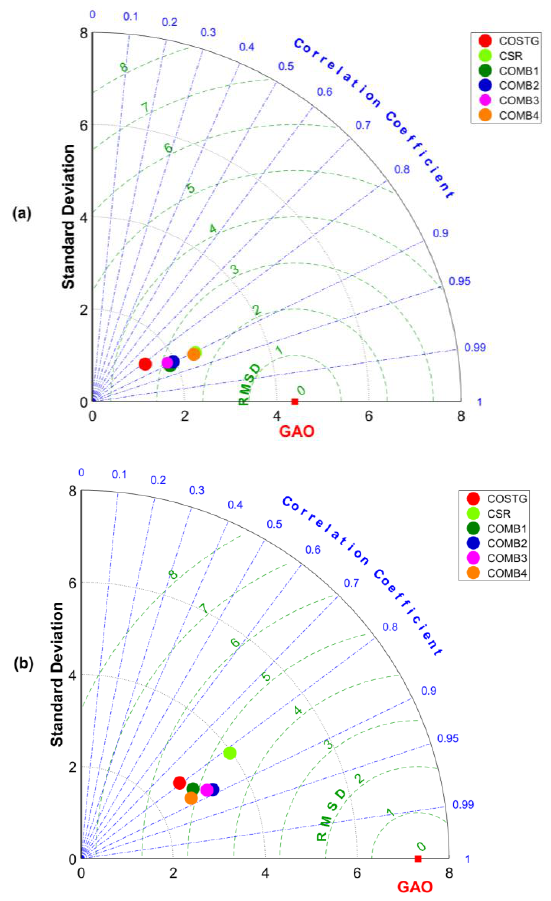
Figure 7. Taylor diagrams showing a comparison of seasonal χ 1 ( a ) and χ 2 ( b ) components of GAO (treated as a reference) with gravimetric excitation determined from a single GRACE/GRACE-FO solution (CSR), combined GRACE/GRACE-FO solution (COST-G), and the four combined solutions developed in this study (COMB1, COMB2, COMB3, and COMB4). The critical value of the correlation coefficient for seasonal variation for 90 independent points and a 95% confidence level is 0.17, and the standard error of the difference between the two correlation coefficients is 0.15. To further study seasonal variations, we decomposed them into annual prograde, annual retrograde, semiannual prograde, and semiannual retrograde parts and show their amplitudes and phases (Figures 8 and 9), which is a common approach for testing such oscillations [5,6,20,62]. Figure 8 demonstrates that for the observed hydrological signal in PM excitation (GAO), the retrograde component is characterized by higher amplitudes than for the prograde term, whereas for gravimetric excitations we observe the opposite situation. This characteristic is also nicely visualized in amplitude spectra (Figure 4). In general, all gravimetric excitation series underestimate annual amplitudes observed for GAO and these differences are more prominent for the retrograde term (Figure 8). The amplitude differences between GAO and COMB-based series are between 2.25 and 2.5 mas for the prograde term and between 3.99 and 4.35 mas for the retrograde term. Nota- bly, COST-G-based series is characterized by the smallest amplitudes of annual oscilla- tions, therefore, the use of this solution for the analysis of annual changes in PM excitation